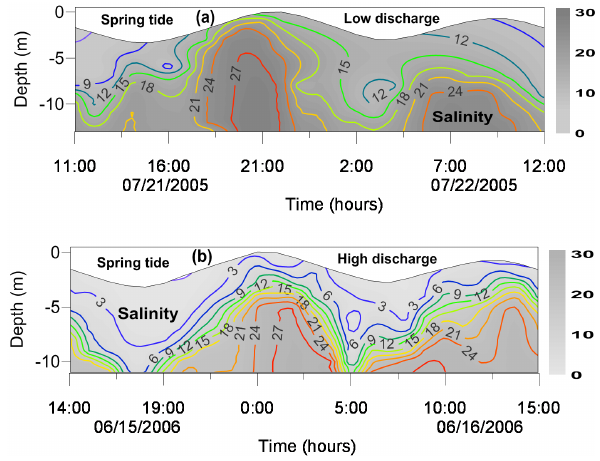
Fig. 3. Time-depth distributions of the salinity profile during spring tide, with low river discharge (28m 3 s − 1 ) on 21–22 July 2005 (a) , and with high river discharge (120m 3 s − 1 ) on 15–16 June 2006 (b) over a tidal cycle at station 7.